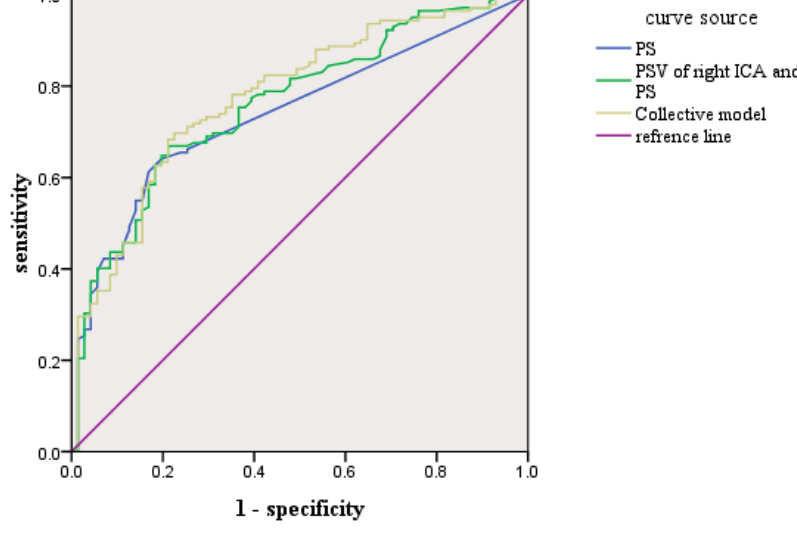
Figure 1. Receiver operating characteristic curve for the collective model. Collective model: including carotid ultrasonography (PSV of right ICA, PS) and age; PS: Carotid artery plaque score. AUC was obtained by receiver operating characteristic curve of the collective model. AUC: 0.778; sensitivity: 0.782; specificity: 0.648. In addition, AUC was